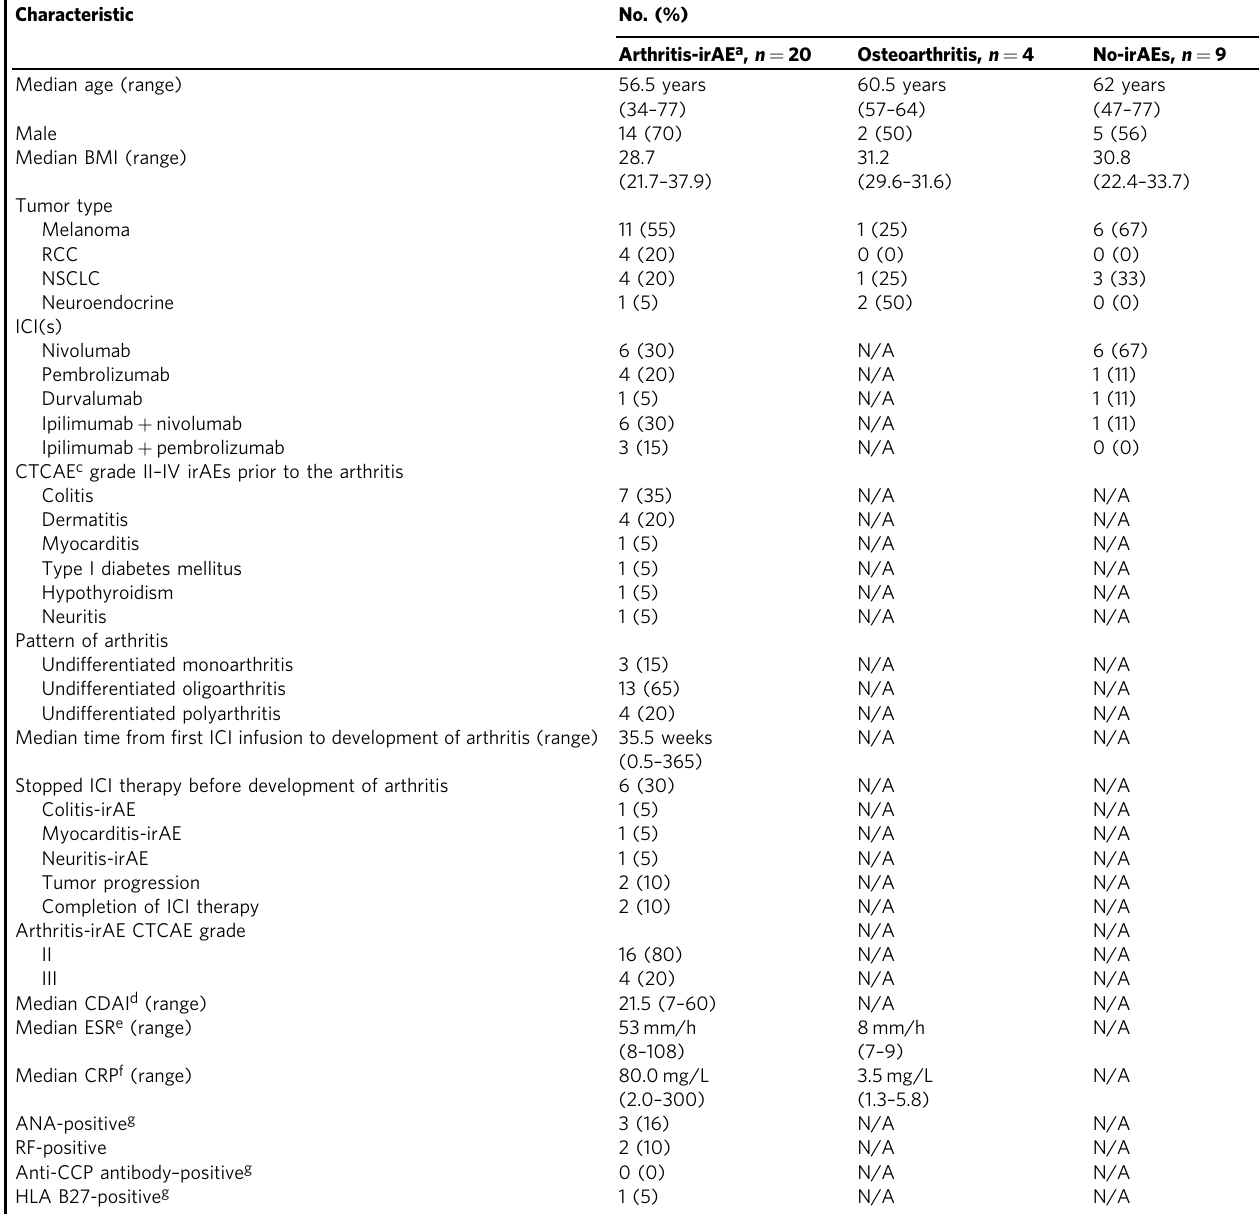
Table 1 Demographic and clinical characteristics of the patients in our study a .